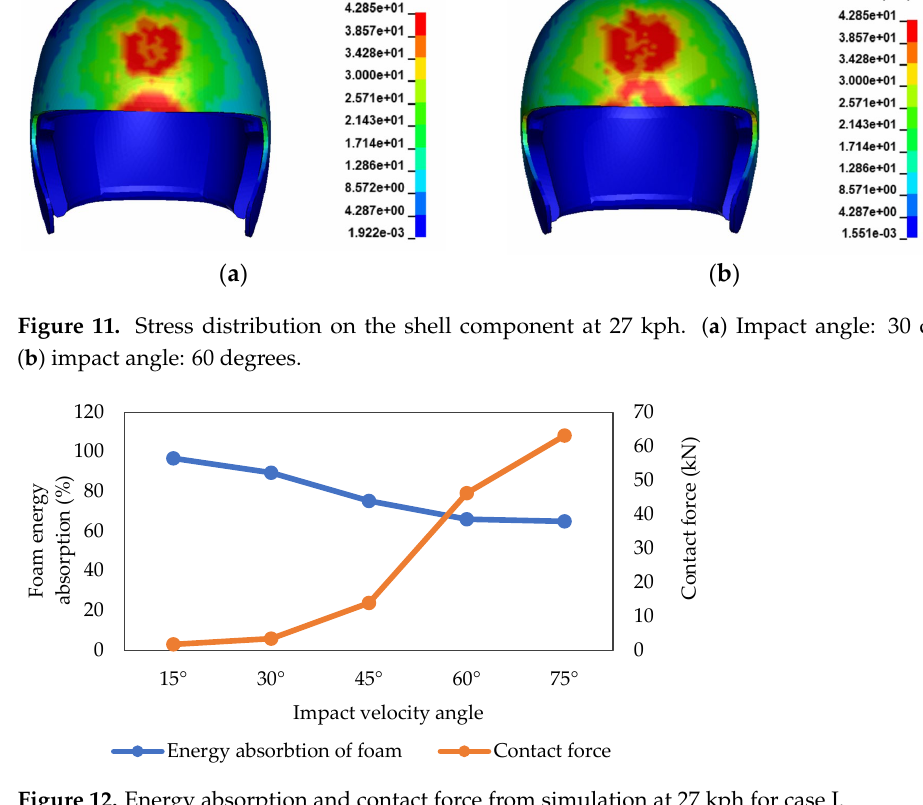
Figure 12. Energy absorption and contact force from simulation at 27 kph for case I.